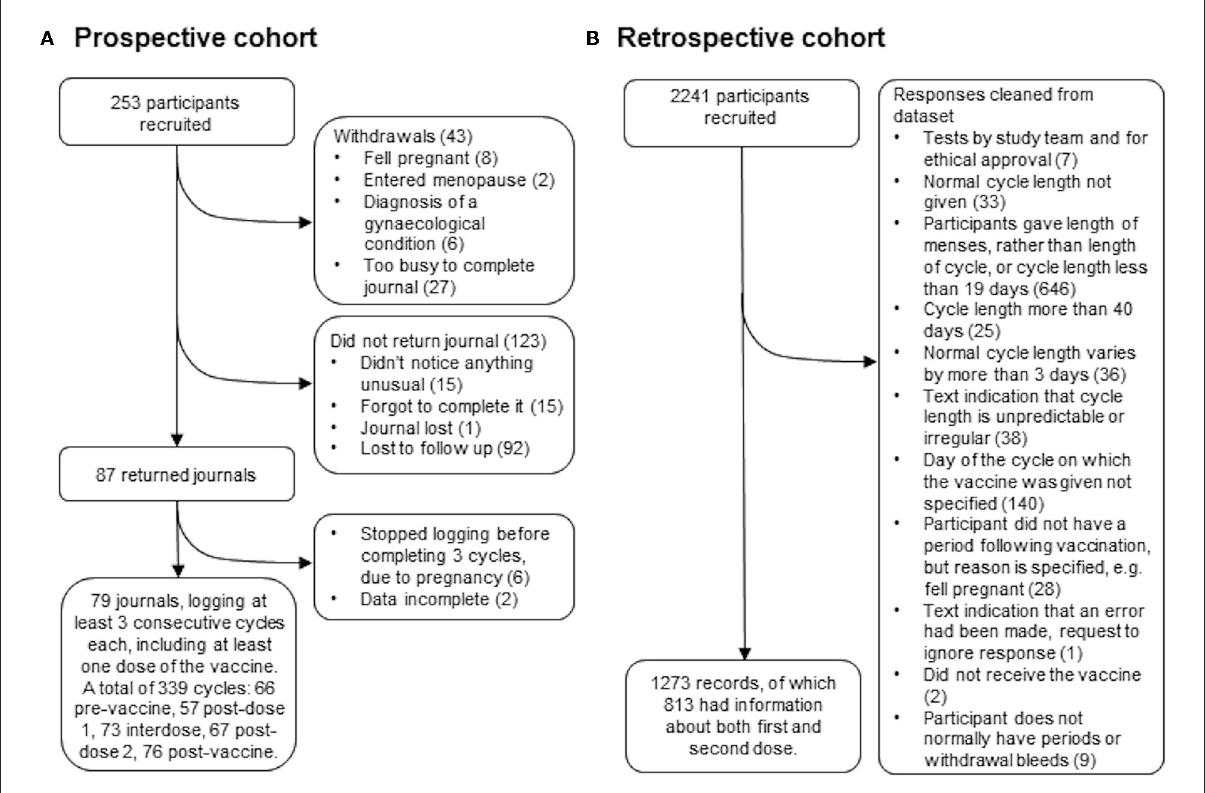
FIGURE1 STROBE flowcharts for the prospective (A) and retrospective (B)